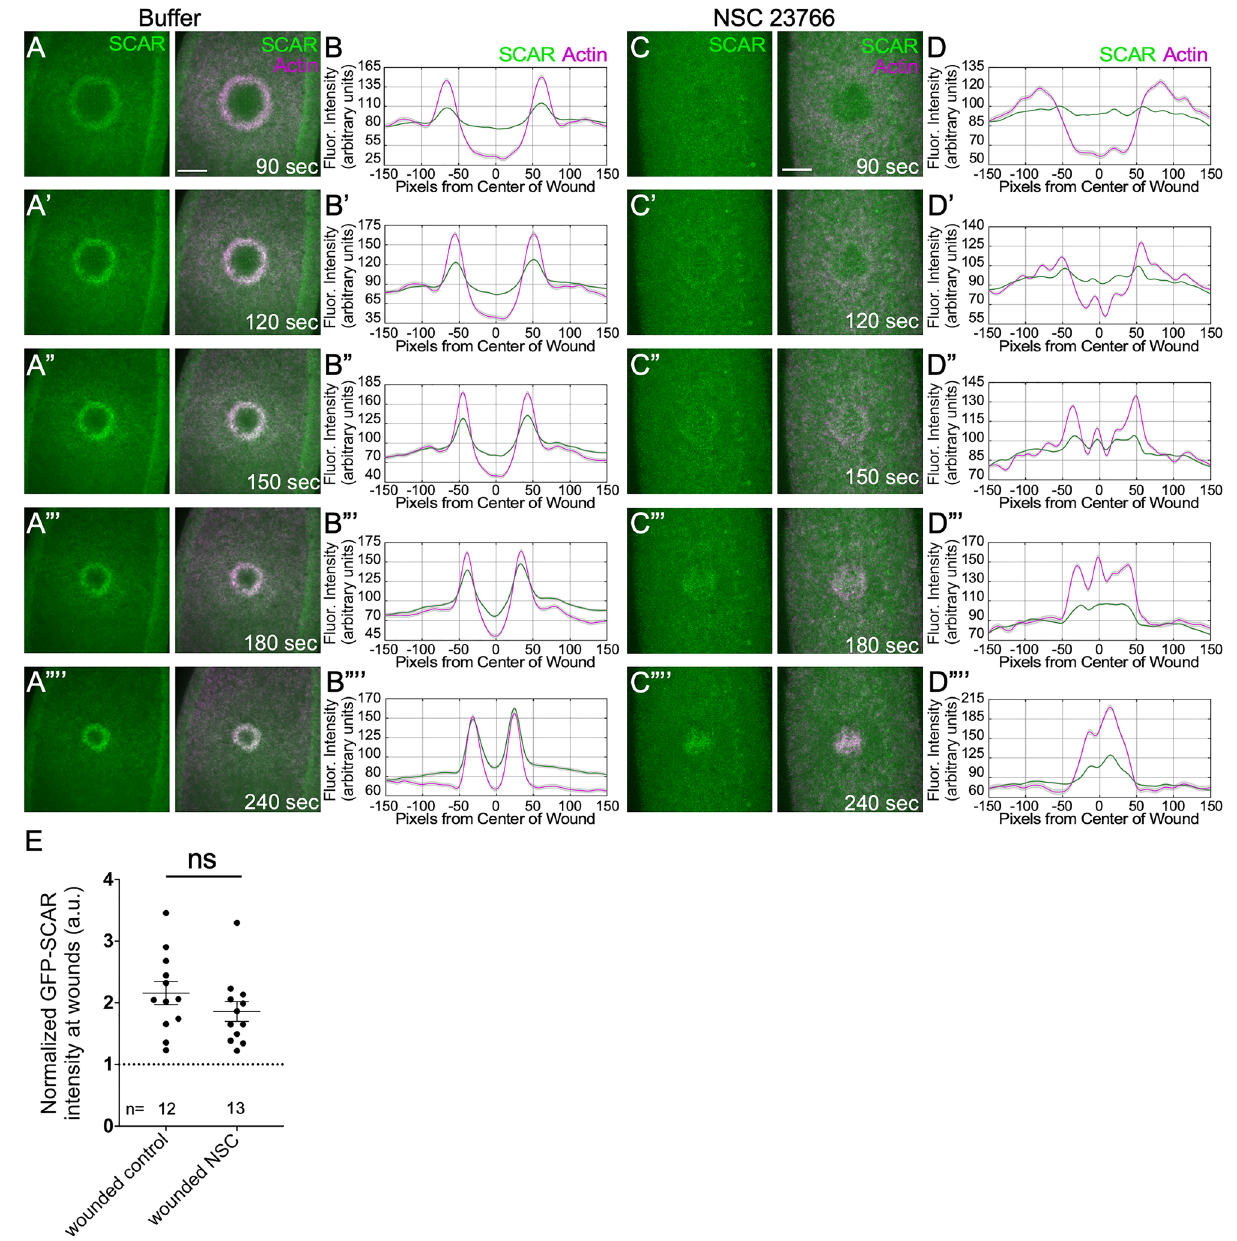
Figure 2. SCAR is recruited to cell wounds in the absence of Rac activity. ( A - A”” ) Confocal projection images of buffer-injected embryos co-expressing GFP-SCAR and an actin reporter (sStMCA) at the time points indicated. ( B - B”” ) Fluorescence intensity (arbitrary units) profiles across the wound area in ( A - A”” ), respectively. ( C – C”” ) Confocal projection images of NSC 23766-injected embryos co-expressing GFP-SCAR and an actin reporter (sStMCA) at the time points indicated. ( D - D”” ) Fluorescence intensity (arbitrary units) profiles across the wound area in ( C – C”” ), respectively. ( E ) Dotplot of GFP-SCAR recruitment to wounds in control (buffer-injected) and NSC 23766-injected embryos at 240 s post-wounding. Scale bars: 20